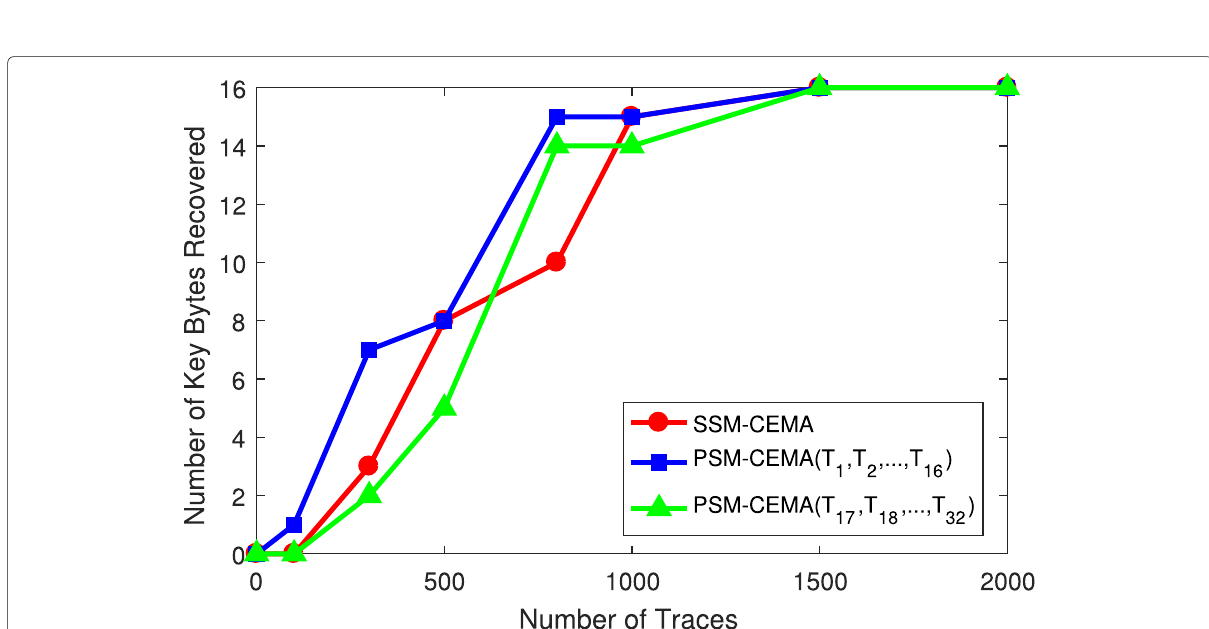
Fig. 9 The experimental results of SSM-CEMA and PSM-CEMA in T 2 G - S 1 G encryption mode. PSM-CEMA( T 1 , T 2 ,..., T 16 ) and PSM-CEMA( T 17 , T 18 ,..., T 32 ) denote CEMAs with PSM based on the leakages from respectively the first half and the second half of threads in a